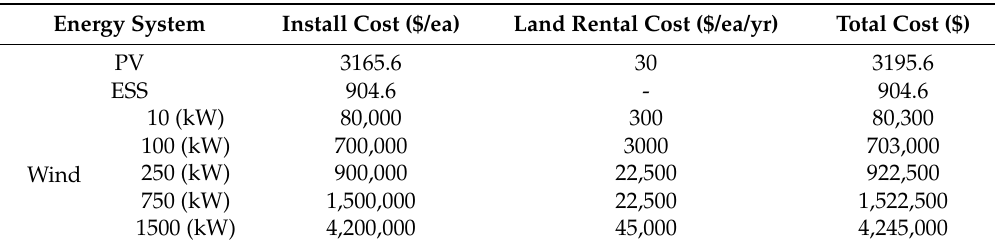
Table 6. Installation costs used in the evaluation.